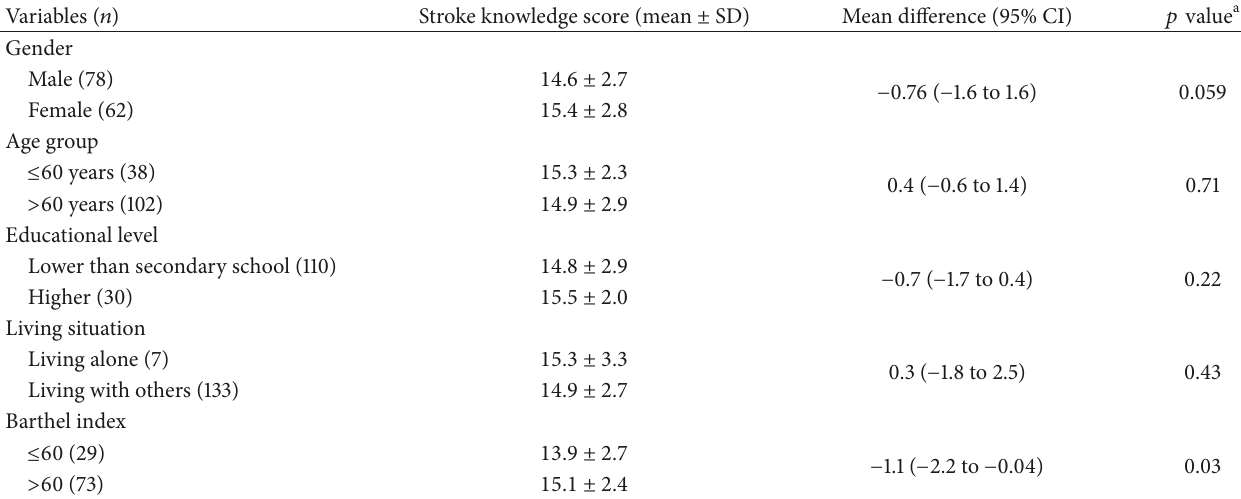
Table 5: Relation between stroke knowledge score (full score 17) and other